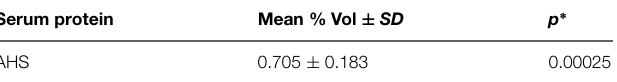
TABLE 2 | Mean percentage of volume contribution of AHS in pre-treatment sera.